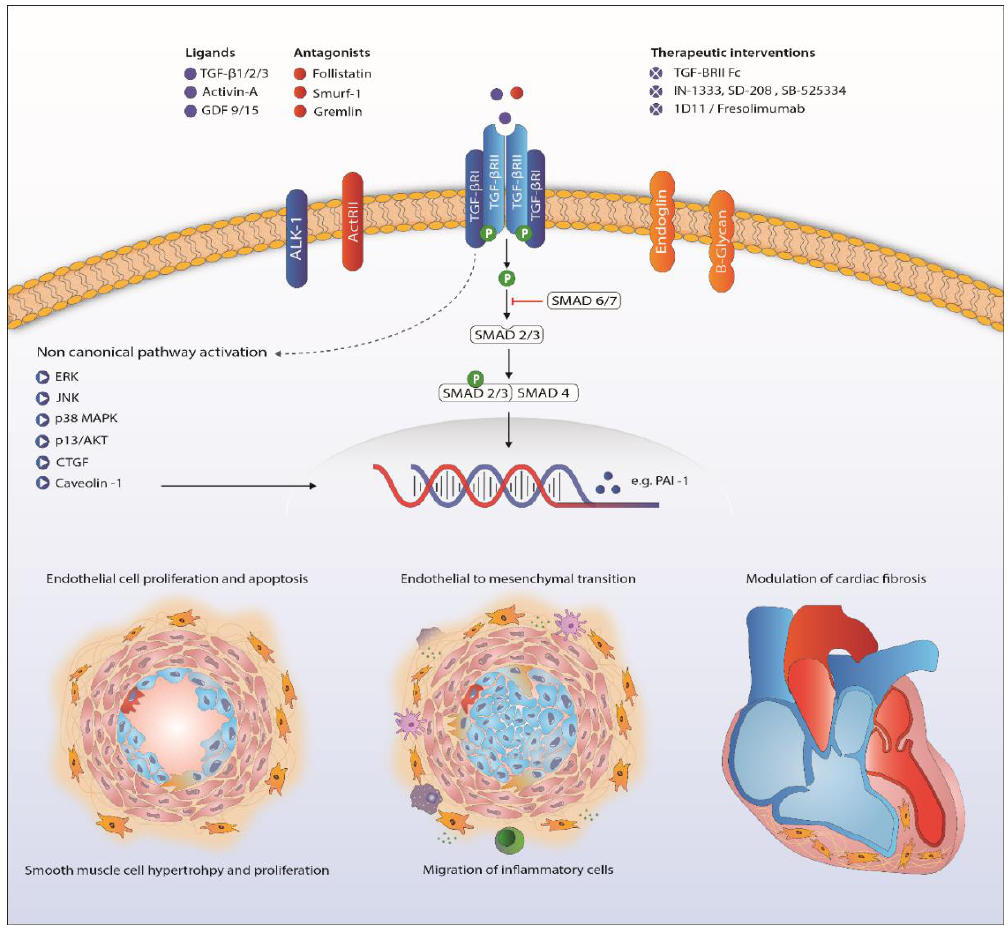
Figure 2. Proposed mechanism of TGF‐β signaling in the pathogenesis of pulmonary arterial hypertension. Abbreviations: ActRII, Activin receptor type II; AKT, protein kinase B; ALK1, activin receptor‐like kinase 1; CTGF, connective tissue growth factor; ERK, extracellular signal‐regulated kinases; GDF, growth/differentiation factor; JNK, c‐Jun N‐terminal kinases; MAPK, mitogen‐activated protein kinase; PAI‐1, plasminogen activator inhibitor‐1; TGF‐β, transforming growth factor β. TGFBRII, TGF‐β receptor type II.